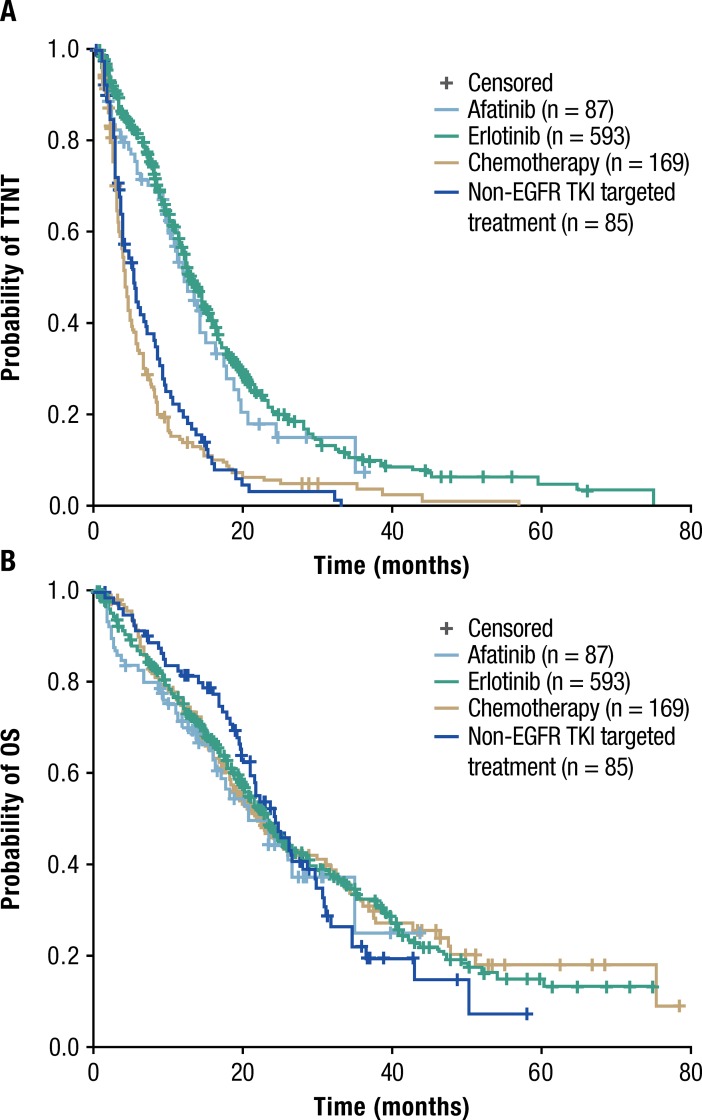
Kaplan-Meier estimates of (A) TTNT, and (B) OS stratified by treatment group.